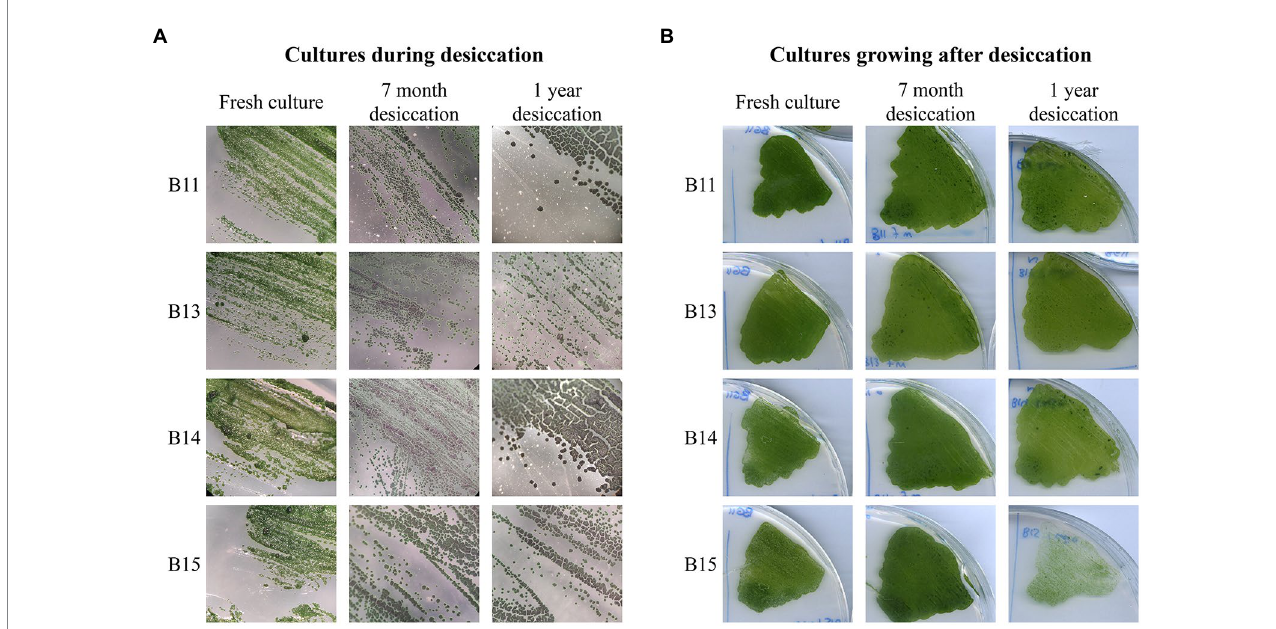
FIGURE 6 Long-term desiccation tolerance in Chroococcidiopsis isolates. (A) Chroococcidiopsis sp. Helios colonies throughout the desiccation process. Fresh cultures were included as a control. (B) Growth observed after 2 weeks on BG11 post rewetting for 7-month and 1-year desiccated culture; a freshly streaked isolate was included as a control.